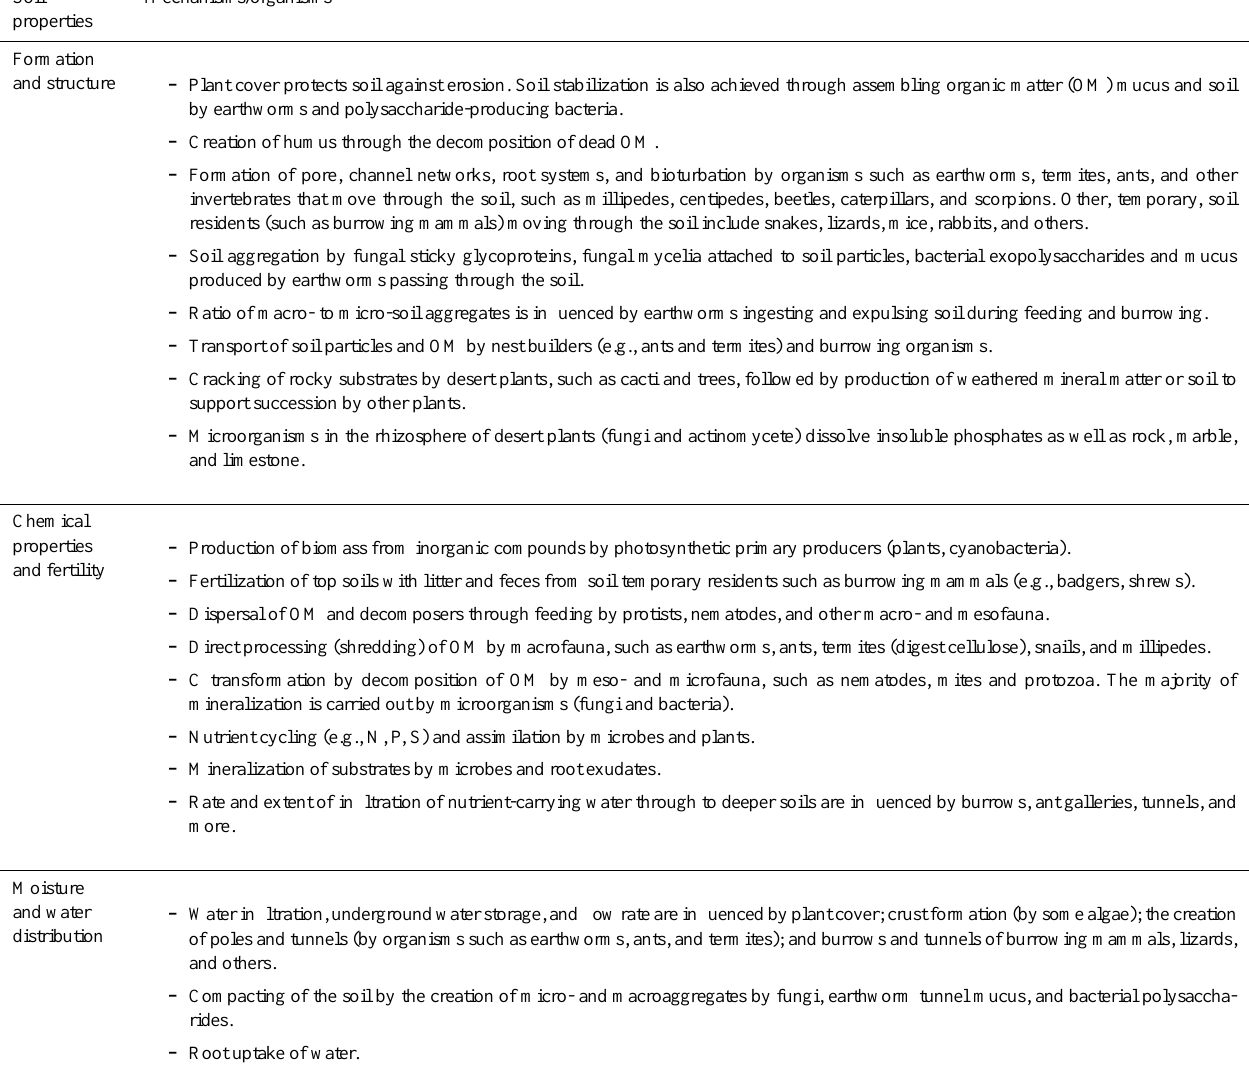
Table 1. Some soil organisms and the soil properties with which they are associated. Soil